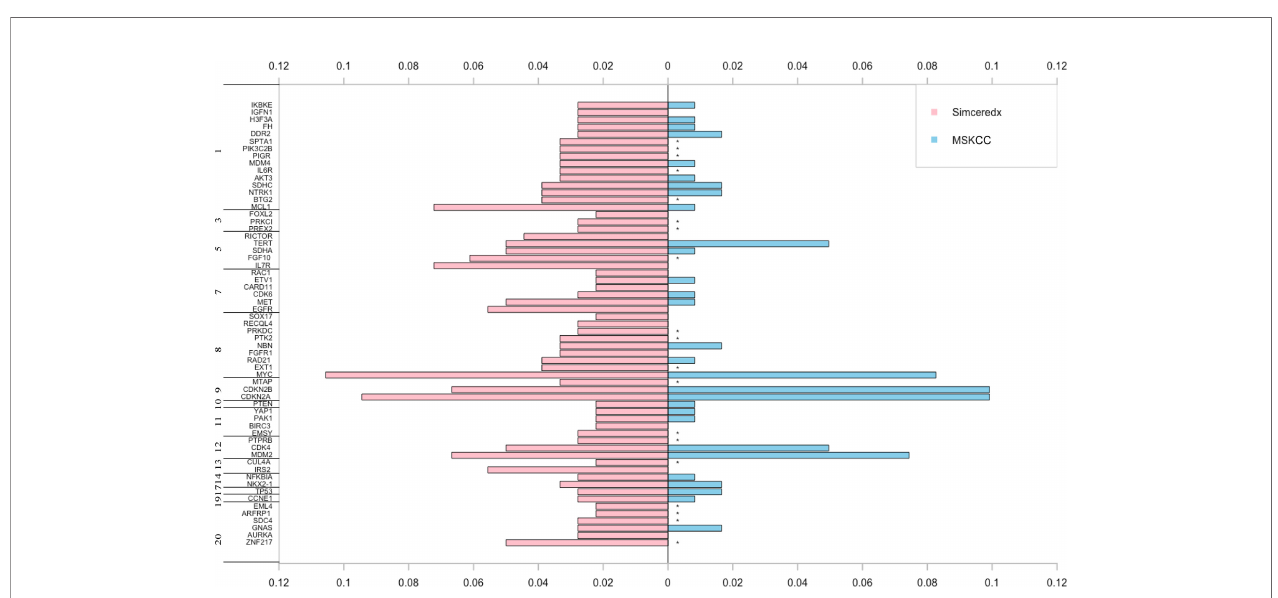
FIGURE 5 | Mutational signatures of ALK/ROS1/NTRK fusion-positive patients. (A) Distribution of mutational signatures in all patients harboring ALK/ROS1/NTRK fusions in our study and that from the MSKCC database. (B) Kaplan-Meier graph for survival probability according to Sig 1, Sig 7, Sig 15, and Sig 30 status.